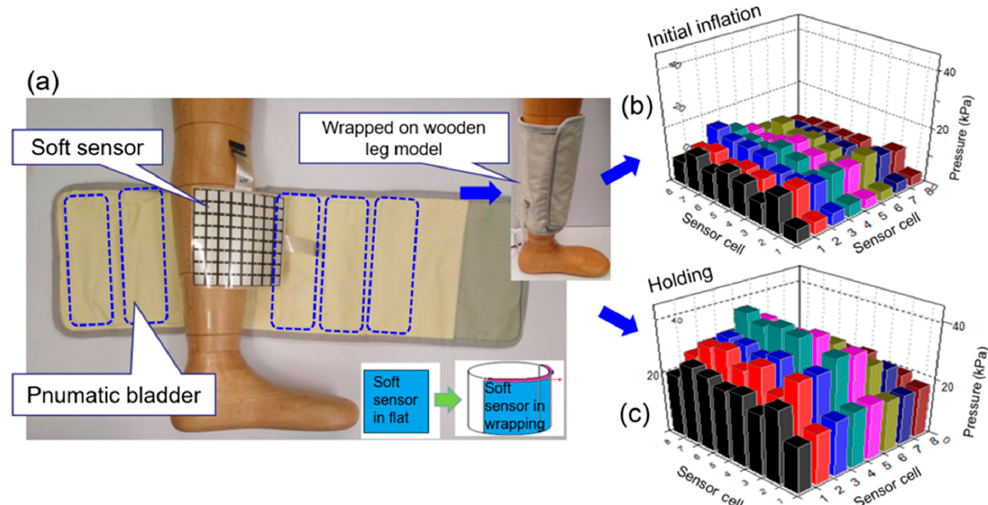
Figure 13. ( a ) A wooden leg model wrapped by the developed matrix soft sensor, ( b ) Morphological pressure mapping at initial inflation and at ( c ) holding stages of one compression cycle by using the IPC device.